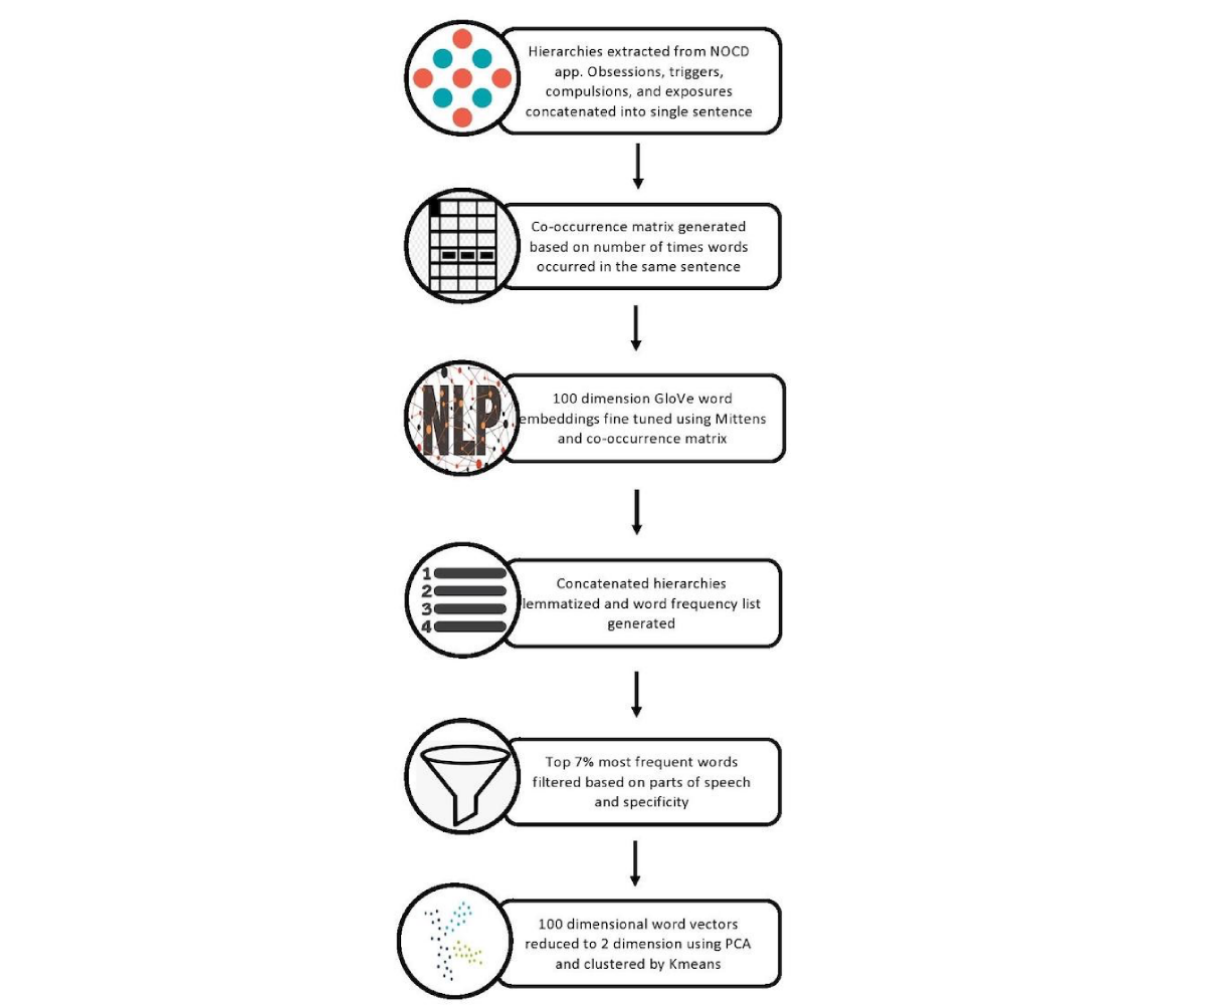
Figure 1. Data extraction and processing steps. GloVe: Global Vectors for Word Representation; PCA: principal component